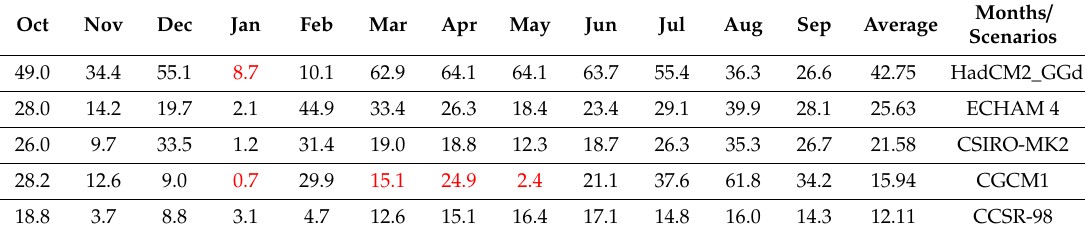
Table3. Percentage(%)ofincrease / decreaseofavailablewaterfor100years(withredfontistheincrease).